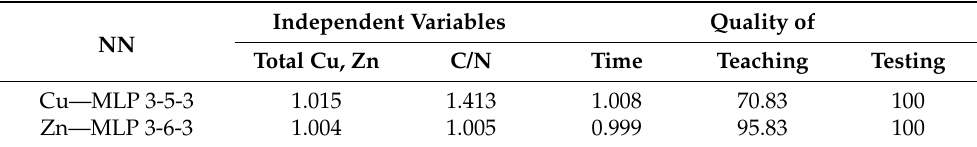
Table 7. Independent variables sensitivity test